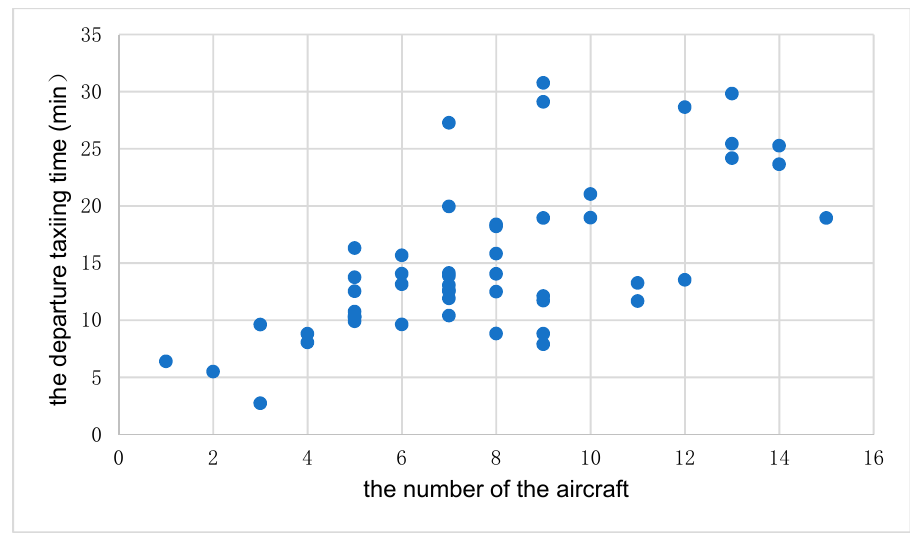
Figure 4. The scatter diagram of the relationship between the departure taxiing time and the number of aircraft.